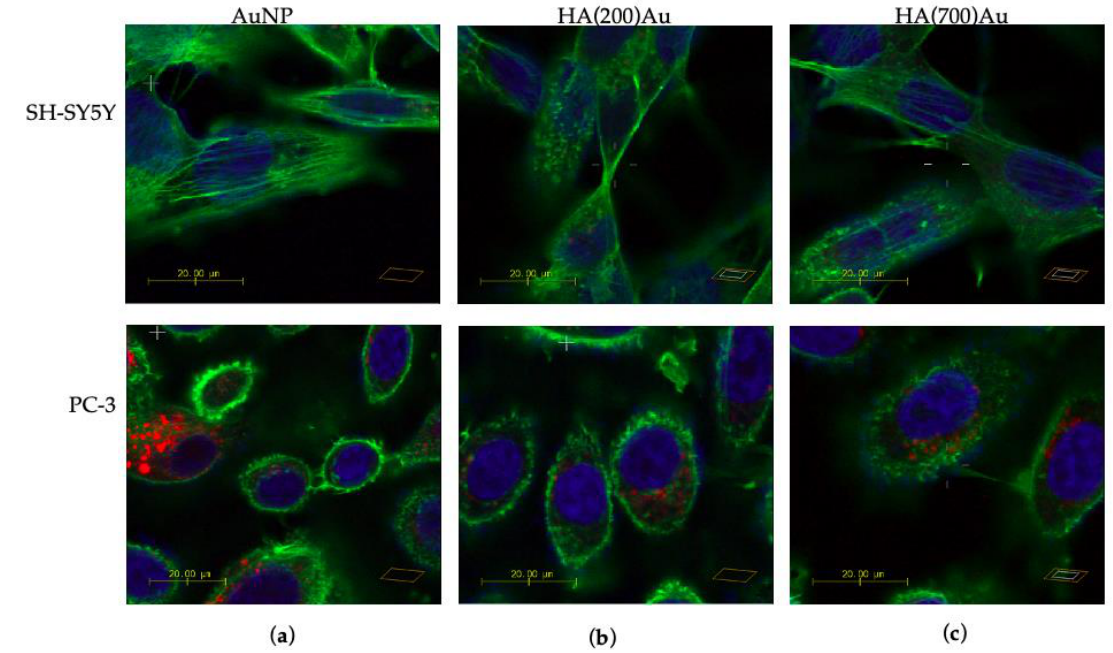
Figure 10. LSM merged confocal micrographs of neuroblastoma (SH-SY5Y, upper panels) and prostate cancer (PC-3, lower panels) cells: in blue, the nuclear staining with Hoechst ( λ ex / em = 405 / 425–450 nm); in green, the cytoskeleton actin staining with Actin Green ( λ ex / em = 488 / 500–530 nm); in red, the lysosomal staining with Lysotracker Red ( λ ex / em = 543 / 550–600 nm). Cellular treatments were carried out for 90 min with ( a ) AuNP (0.005 nM = 5.5 × 10 2 NP / mL); ( b ) HA(200)Au (0.0010 nM = 7.2 NP / mL, 0.1% w / v HA); ( c ) HA(700)Au (0.0011 nM = 2.5 × 10 1 NP / mL, 0.1% w / v HA). Scale bar = 20 µm.